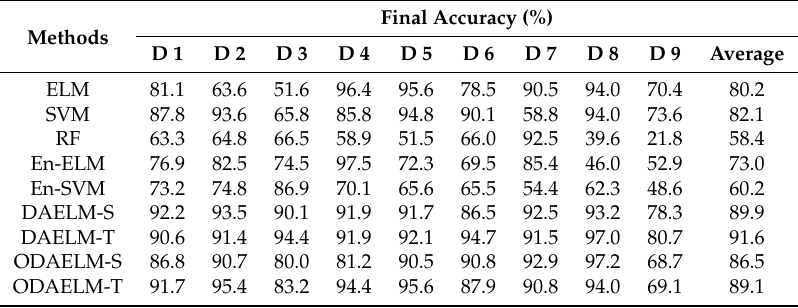
Table 6. Comparisons of final classification accuracies using setting 3.